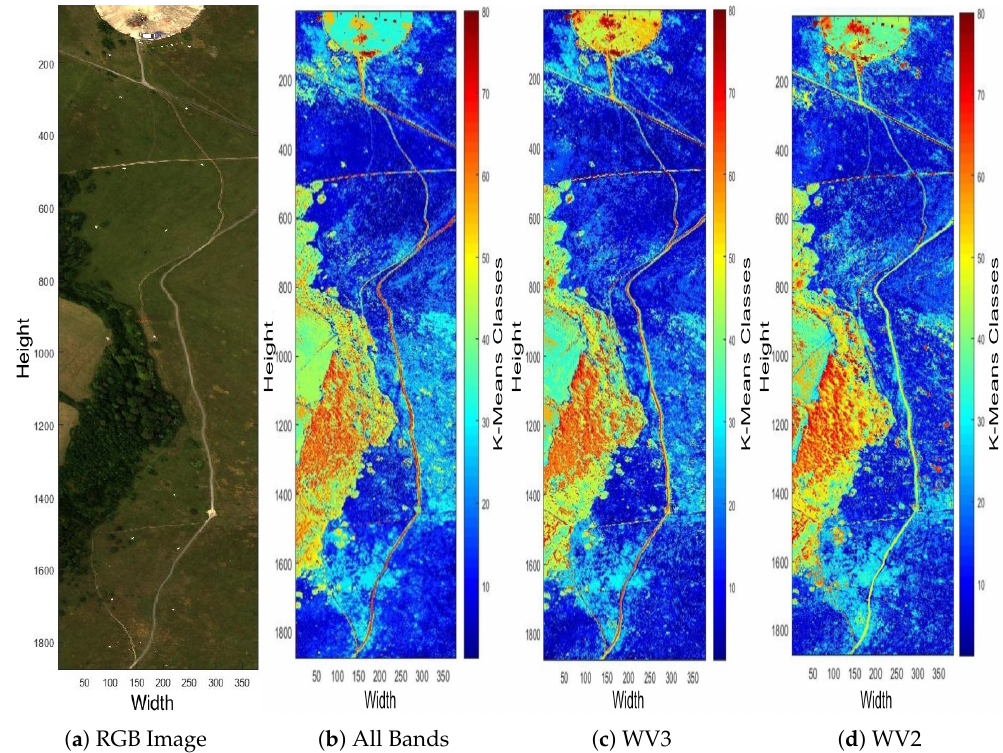
Figure 3. False-colour classification maps displayed with all 448 bands ( b ), 16 centre wavelengths of the WV3 sensor ( c ) and 8 centre wavelengths of the WV2 sensor ( d ) classified by K-Means for H23 Dual scene into 80 classes with MATLAB’s default maximum of 100 iterations. The figures show >99% of classification similarities despite of the very small number of spectral bands (8 bands) that has been utilised in ( d